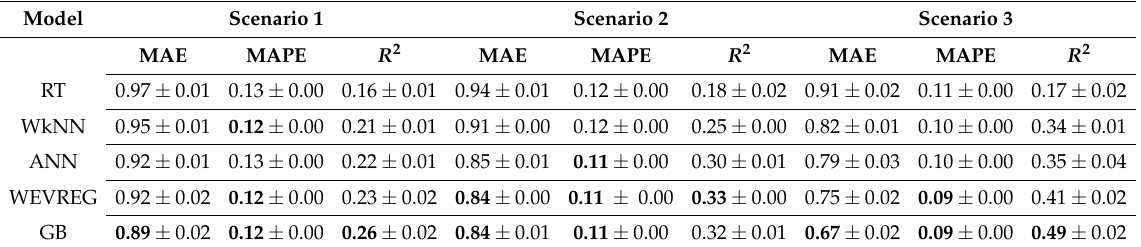
Table 6. Models performance with all features (the lower is the better for Mean Absolute Error (MAE) and Mean Absolute Percentage Error (MAPE); the higher the better for R 2